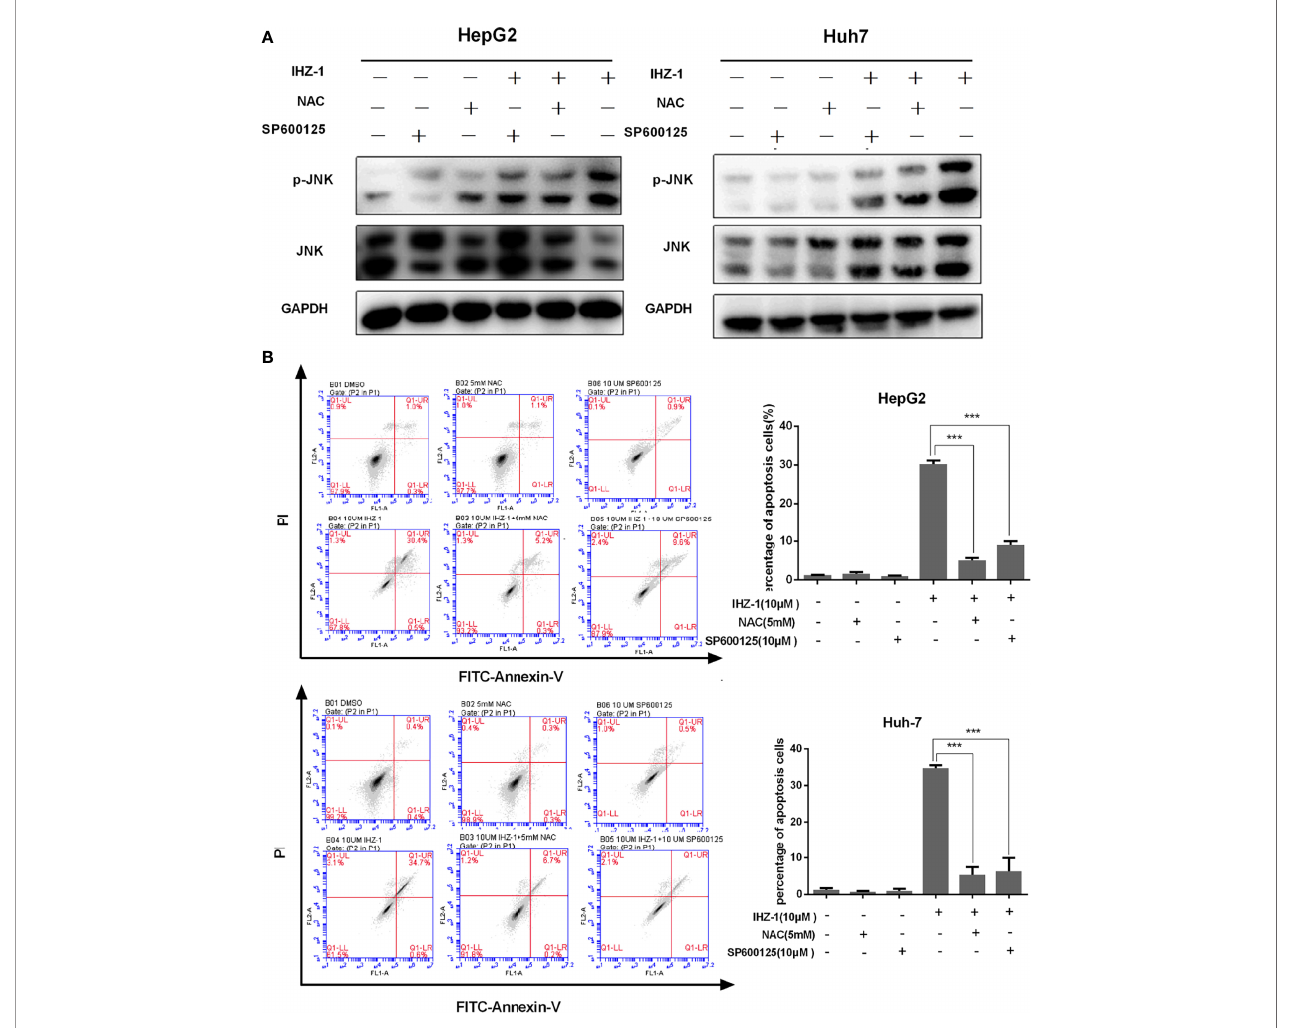
FIGURE 2 | IHZ-1 caused apoptosis through activating ROS/JNK cascade in HCC cells. (A) Cells were incubated with IHZ-1 and pretreated with NAC or SP600125. Immunoblots of p-JNK and JNK protein expression was quanti fi ed. (B) The apoptosis cells were evaluated by fl ow cytometry using Annexin-V/PI double staining. ***p <